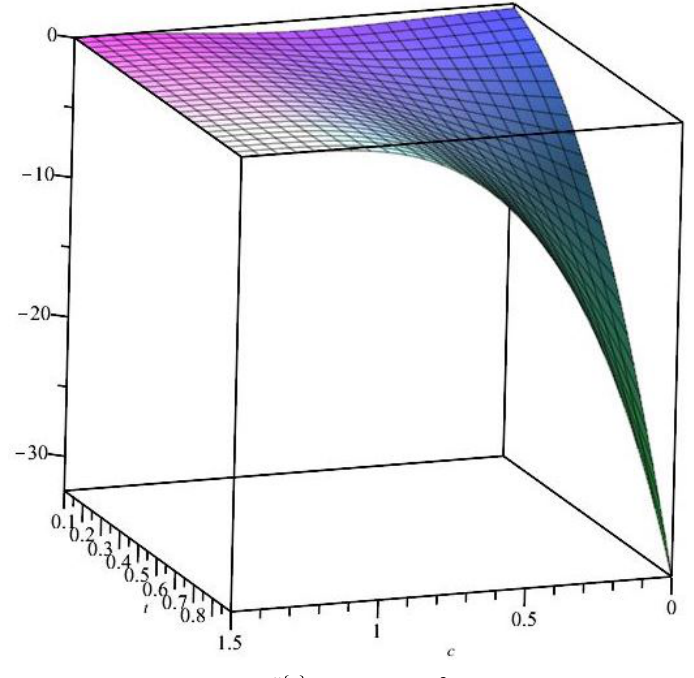
Figure 4. The variation of ˜ S { c } w.r.t. c and θ 2 : = t